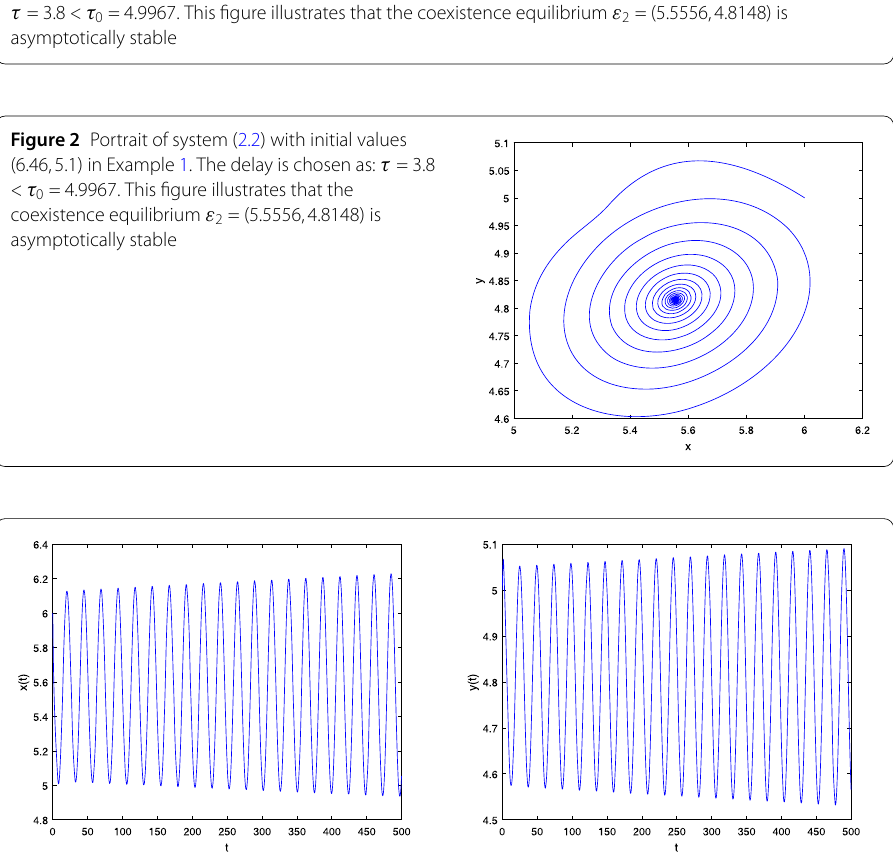
Figure 3 Waveform plots of system (2.2) with initial values (6.46,5.1) in Example 1. The delay is chosen as: τ = 5.1 > τ 0 = 4.9967. This figure illustrates that the coexistence equilibrium ε 2 = (5.5556,4.8148) is